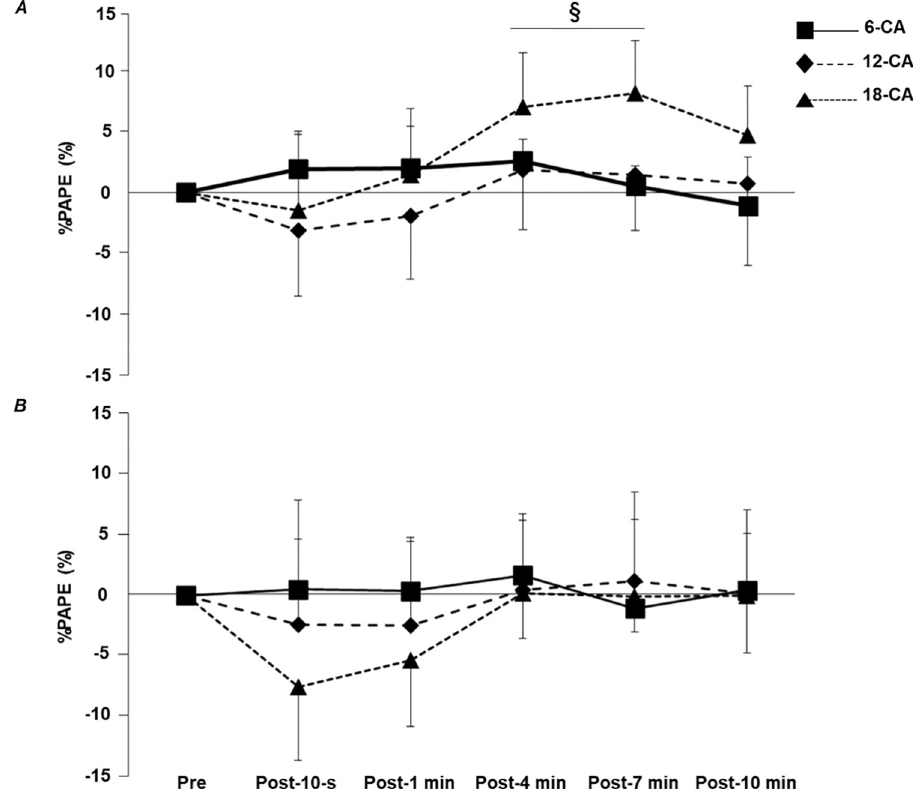
Fig 5. Time-course changes in %PAPE after each CA for ( A ) stronger individuals and ( B ) weaker individuals. CA, conditioning activity. Values are means ± standard deviation. The statistical difference is set at p < 0.05: difference from Pre in 18-CA §